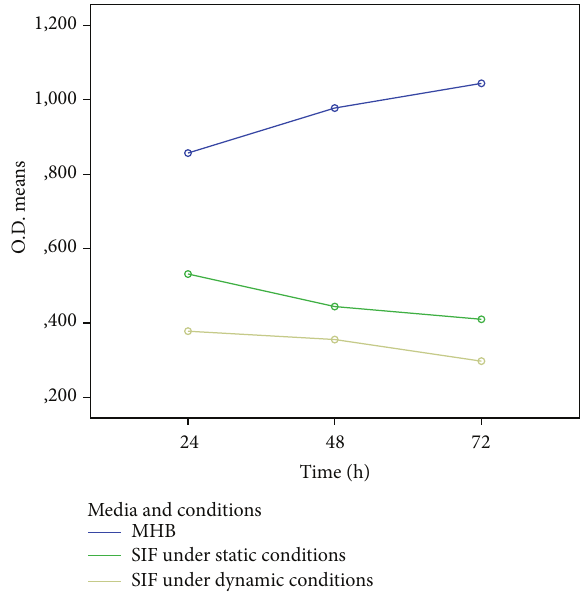
Figure 1: Time course of biofilm production by 133 Salmonella Typhimurium 1,4,[5],12:i:- isolates using an Alamar Blue microtiter assay applied in different incubation conditions. Mean and standard deviation for MHB were at 24 h 0,856 ± 0,095, at 48 h 0,977 ± 0,105, and at 72 h 1,044 ± 0,118. SIF under static conditions were at 24 h 0,531 ± 0,217, at 48 h 0,443 ± 0,222, and at 72 h 0,409 ± 0,146. SIF under agitation conditions were at 24 h 0,377 ± 0,136, at 48 h 0,355 ± 0,142, and at 72 h 0,297 ± 0,108. MHB: Mueller Hinton Broth; SIF: simulated intestinal